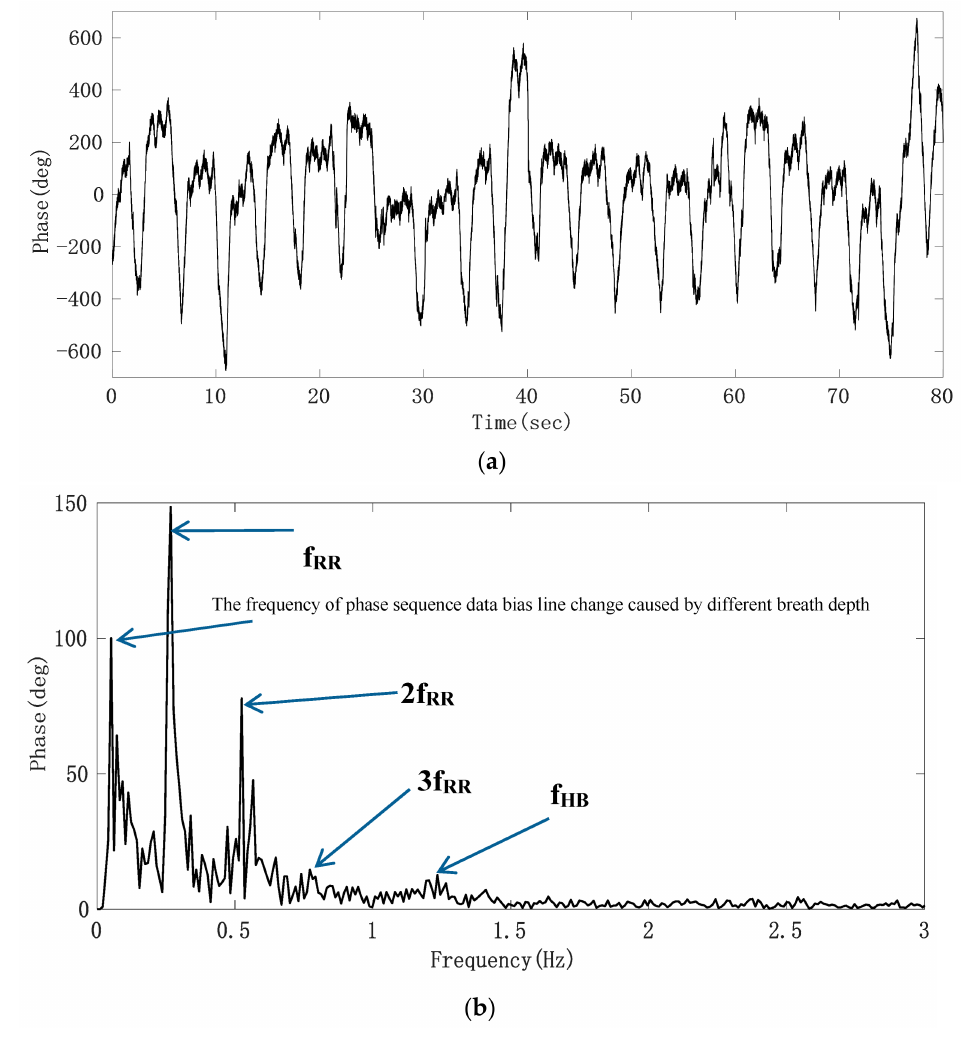
Figure 8. Experimental results of the target; ( a ) raw phase sequence data; ( b ) FFT spectrum of raw phase sequence